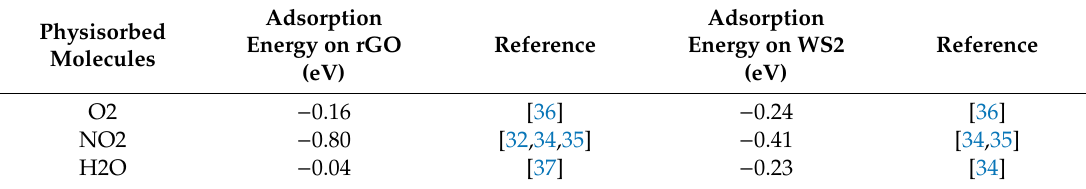
Table 2. Adsorption energy on rGO and WS 2 of O 2 , NO 2 and H 2 O molecules. Note that negative adsorption energy means that the adsorption process is exothermic and energetically